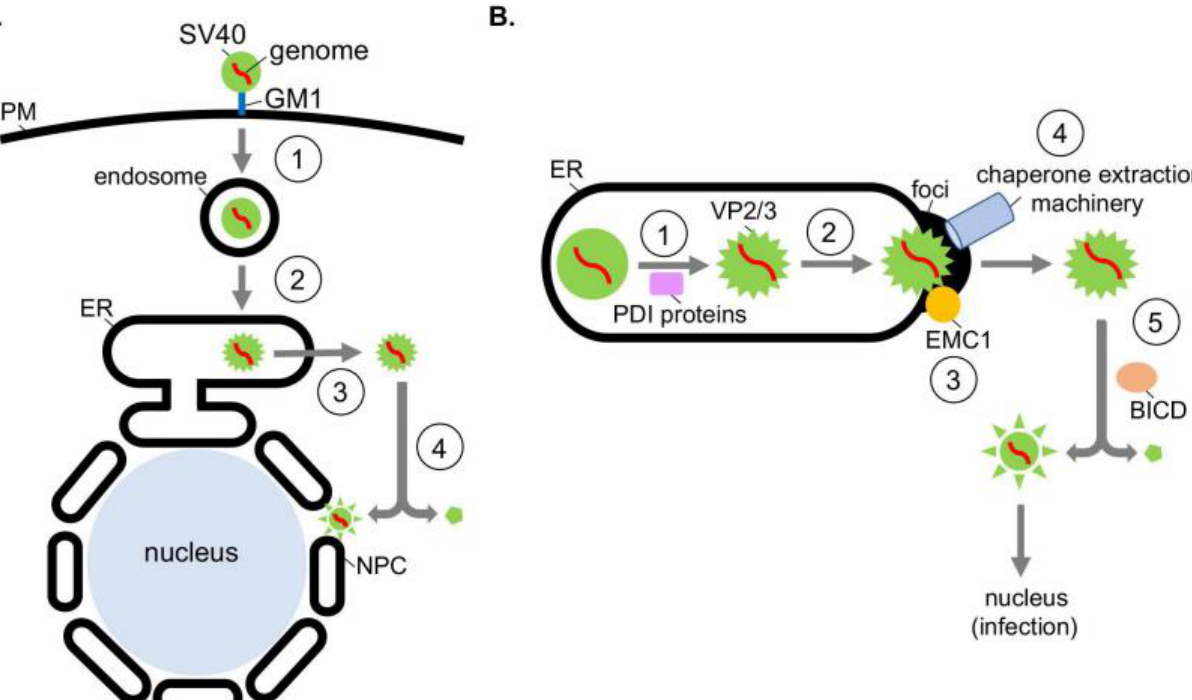
Figure 1. Exploiting ER and cytosolic chaperones during ER escape and disassembly of polyomavirus SV40. ( A ) Polyomavirus SV40 entry pathway. During entry, SV40 undergoes receptor-mediated endocytosis, trafficking to the endosome and then the ER. Here it penetrates the ER membrane to reach the cytosol and then the nucleus to cause infection. ( B ) In the ER, PDI family proteins (PDI, ERp57, and ERdj5) reduce and isomerize the SV40 disulfide bonds (step 1) , while another PDI family member (ERp29) unfolds the VP1 C-terminal arm—these reactions disrupt the viral architecture that exposes the SV40 hydrophobic VP2 and VP3 proteins. As a consequence, a hydrophobic SV40 particle is formed which integrates into the ER membrane (step 2) . SV40 then reorganizes the ER membrane to construct an exit site (called foci) where the virus crosses to reach the cytosol. During foci formation, SV40 directs the ER membrane protein EMC1 to relocate to the foci where it stabilizes the membrane-inserted SV40 (step 3) . SV40 further triggers DNA J protein family members (B12, B14, and C18) to accumulate in the foci—this recruits a cytosol-localized chaperone extraction machinery (Hsc70, Hsp105, Bag2, and SGTA) that propels SV40 into the cytosol (step 4) . The dynein motor adaptor BICD disassembles the cytosol-localized virus (step 5) , forming a subviral particle that enters the nucleus to trigger infection.